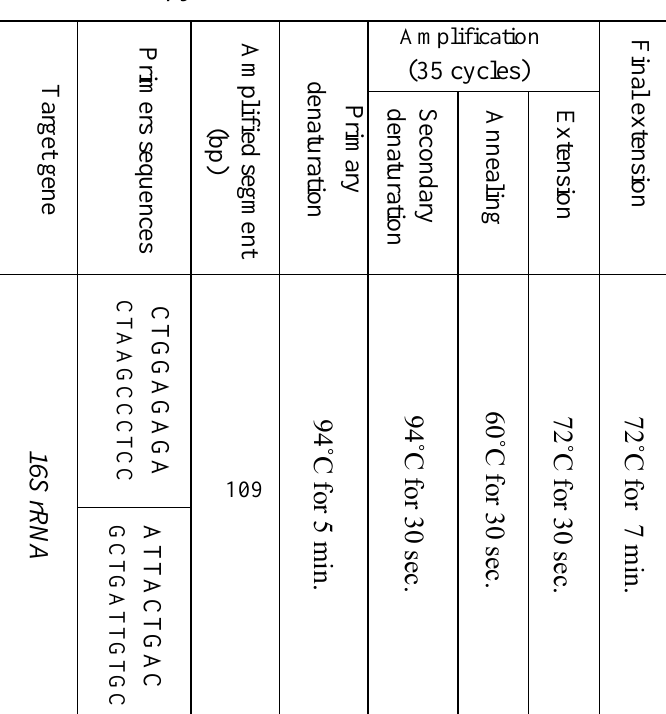
Table 1: Primers used for identification of 16S rRNA of H.